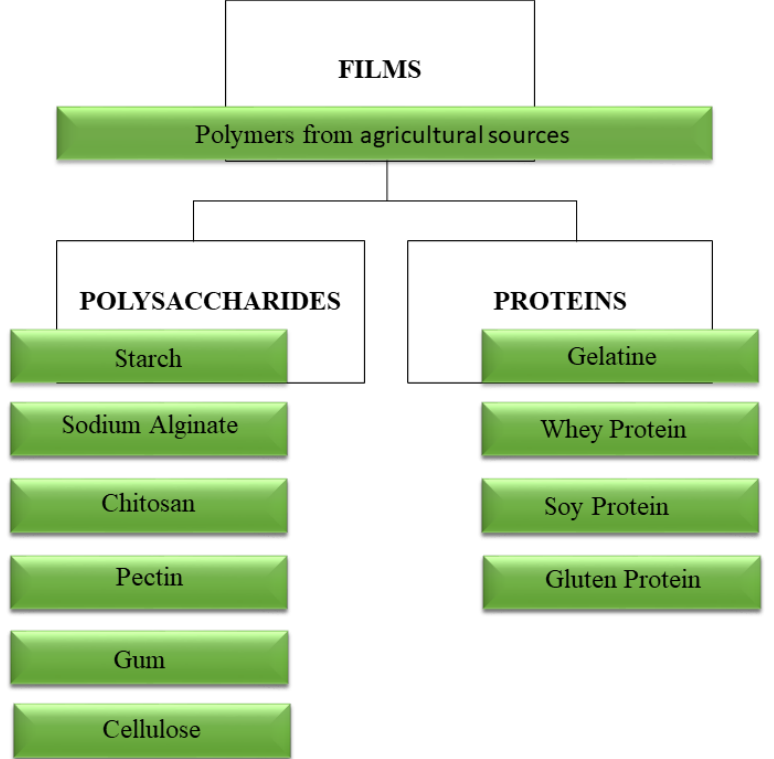
Figure 1. Main polymers of agricultural origin from renewable sources used in the development of biodegradable films.